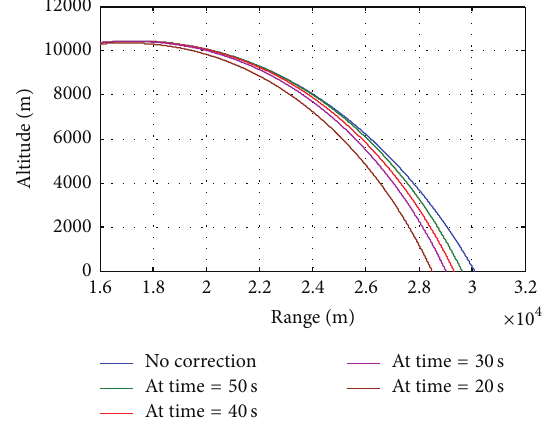
Figure 10: Altitude versus range.